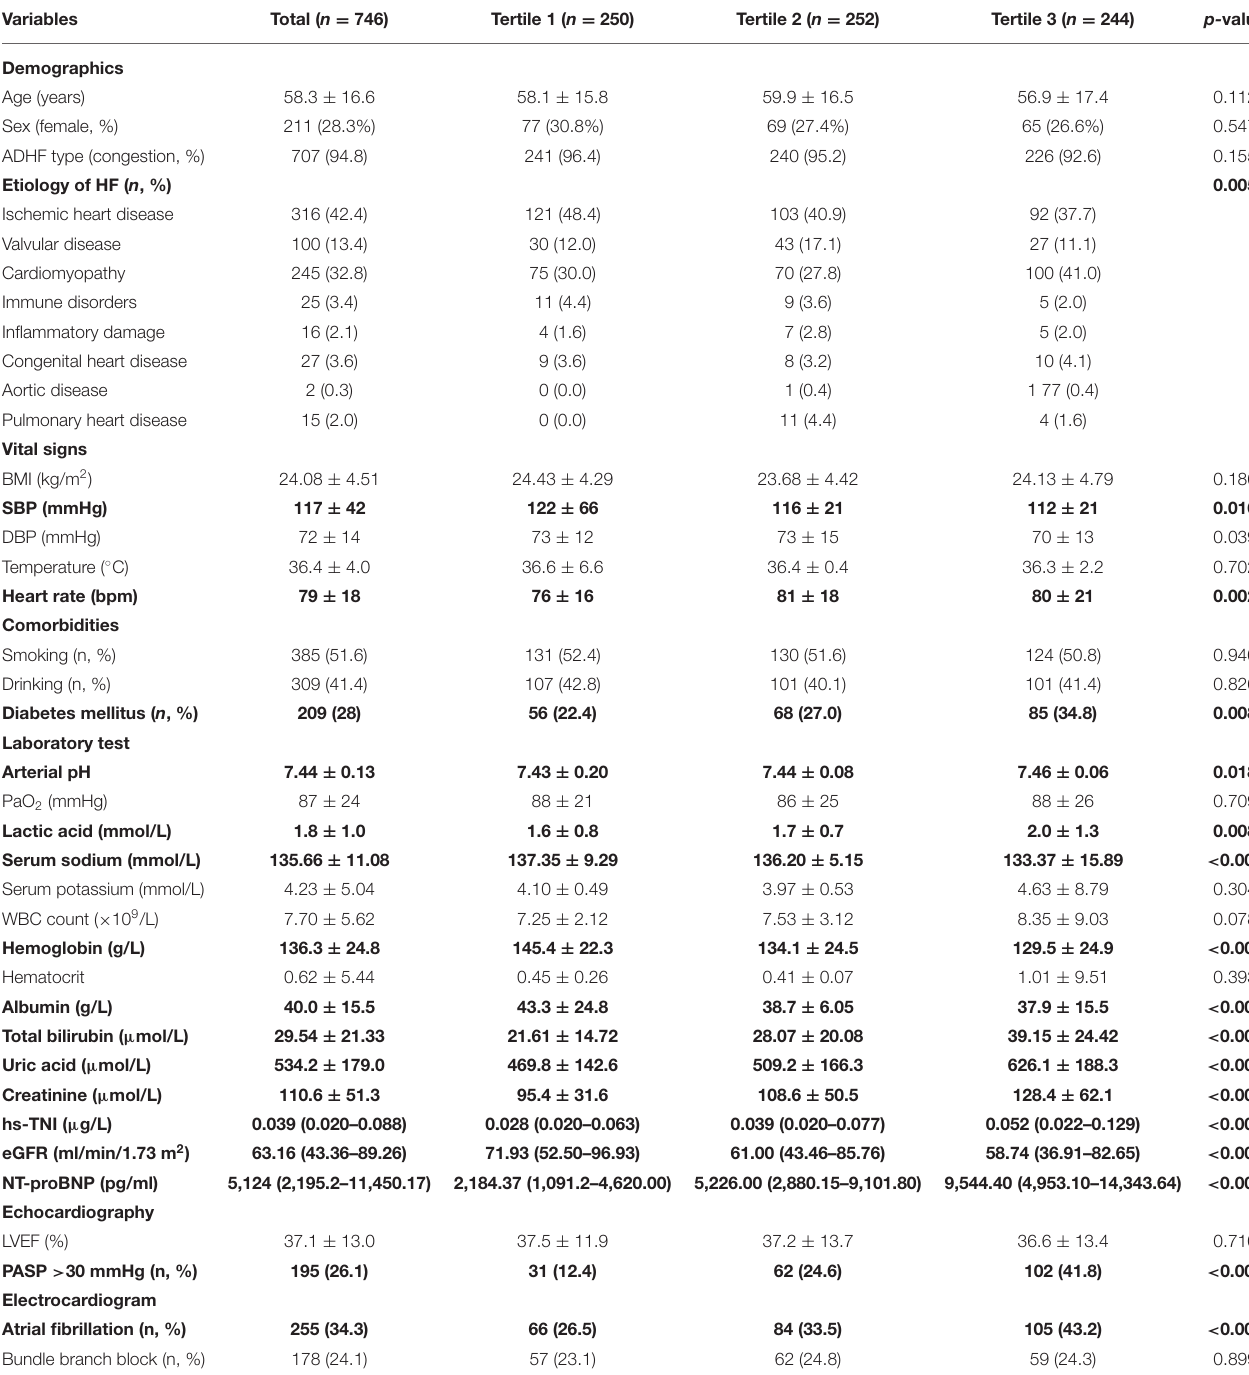
TABLE 1 | Baseline characteristics based on big ET-1